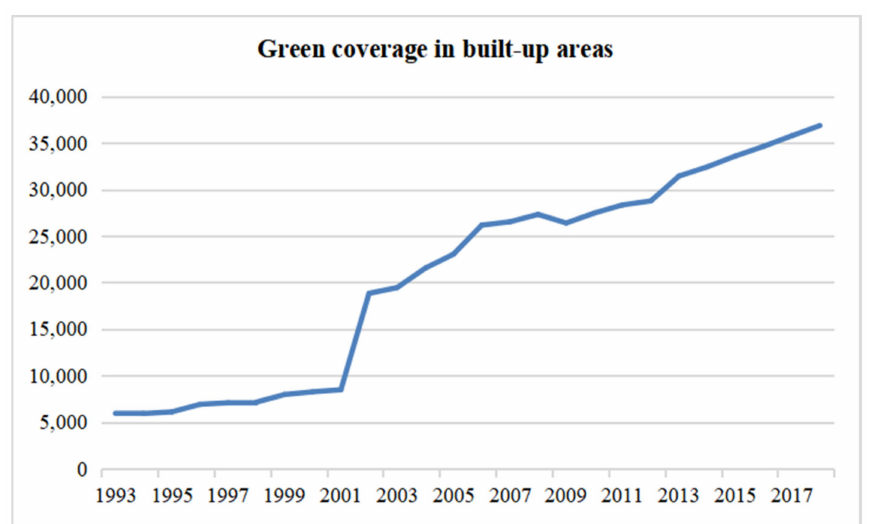
Figure 3. Growth trends in the green coverage in built-up